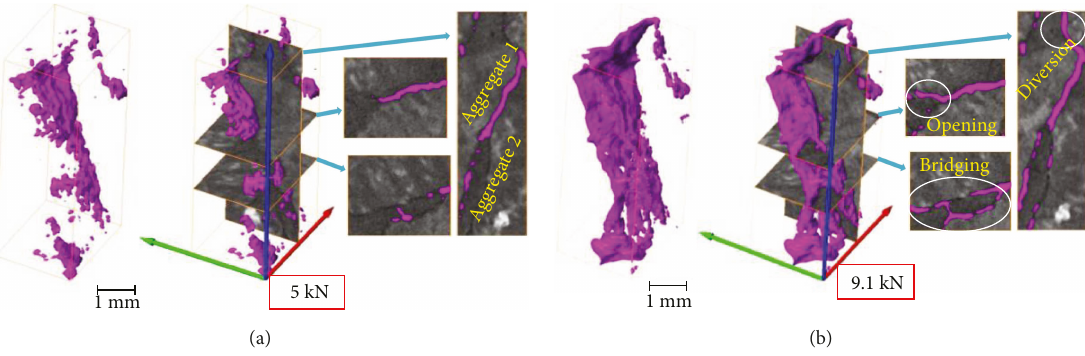
Figure 6: 3D crack surface and slice views under 5 kN and 9.1kN.